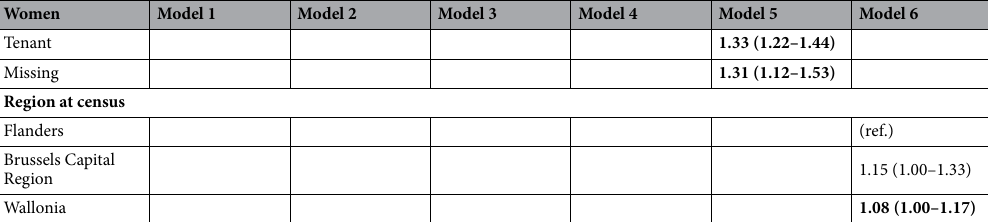
Table 5. Relative 5-year colorectal cancer survival inequalities among the study population aged 50 to 74 years by gender and migrant origin, adjusted for age at time of diagnosis, combined TNM stage and sociodemographic and socioeconomic indicators, Belgium, diagnosed between 2004–2013 and followed until 2017. Model 1 is adjusted for age at time of diagnosis; Model 2 is adjusted for age at time of diagnosis and combined TNM stage at diagnosis; Model 3 is adjusted for age at time of diagnosis, combined TNM stage at diagnosis and civil status; Model 4 is adjusted for age at time of diagnosis, combined TNM stage at diagnosis and educational attainment; Model 5 is adjusted for age at time of diagnosis, combined TNM stage at diagnosis and home ownership; Model 6 is adjusted for age at time of diagnosis, combined TNM stage at diagnosis and region at time of census. Results significant at the p < 0.05-level are in